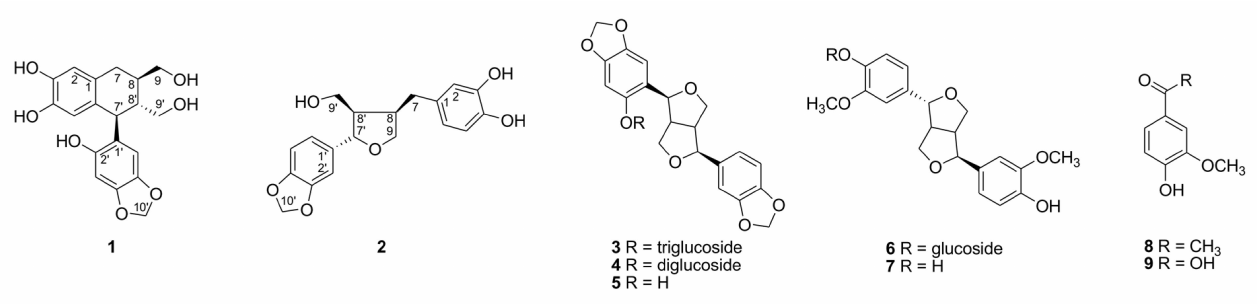
Figure 1. Chemical structures of compounds 1 – 9 isolated from defatted sesame